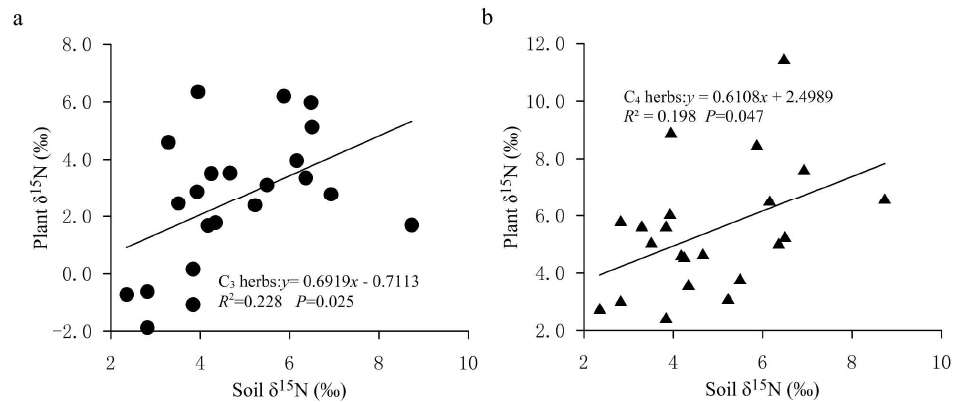
Figure 7. Correlations of δ 15 N of C3 and C4 herbs with surface soil δ 15 N in the study area. ( a ) Relationship between δ 15 N values of C3 herbs and soil δ 15 N values. ( b ) Relationship between δ 15 N values of C4 herbs and soil δ 15 N values.